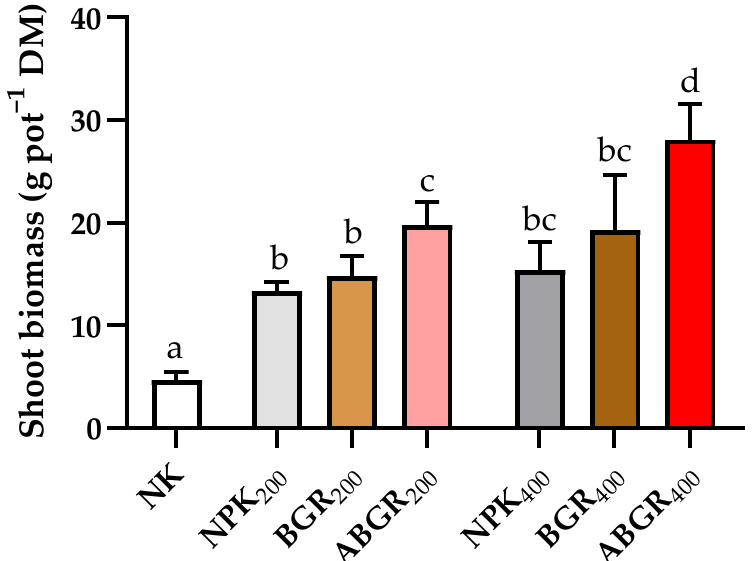
Figure 2. Shoot biomass of maize plants 8 weeks after germination. Values are means ( n = 5) ± SD (bars). Different letters above the bars indicate significant differences ( p ≤ 0.05) between treatments. For treatment abbreviations, see Table 1.